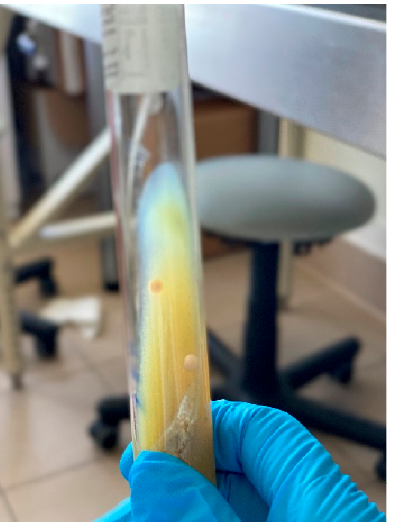
Figure 1. Colonies grown on Herrold’s media with mycobactin.